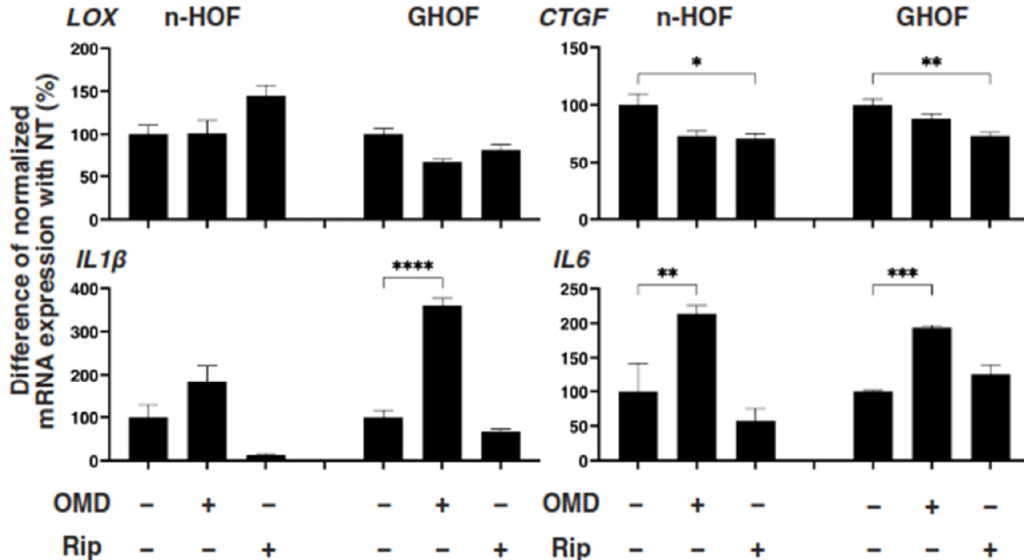
Figure 4. mRNA expression of ECM-regulatory genes and inflammatory cytokines in n-HOFs or GHOF 3D spheroids under several conditions. At Day 6, the n-HOFs 3D spheroids without or with 100 nM omidenepag (OMD) or 10 µ M Ripasudil (Rip) were subjected to a qPCR analysis to estimate the mRNA expression of ECM-regulatory genes ( LOX : lysil oxidase, CTGF : Connective Tissue Growth Factor, EPAS1 : endothelial PAS domain-containing protein 1), and inflammatory cytokines ( IL1 β : interleukin-1 β , IL6 : interleukin-6). Percent difference in the mRNA expressions of these respective genes of n-HOF or GHOF spheroids treated with omidenepag (OMD) or ripasudil (Rip) as above, as compared with their non-treated control (CONT) were plotted. In terms of the results of the GHOF spheroids, corresponding data reported in our previous